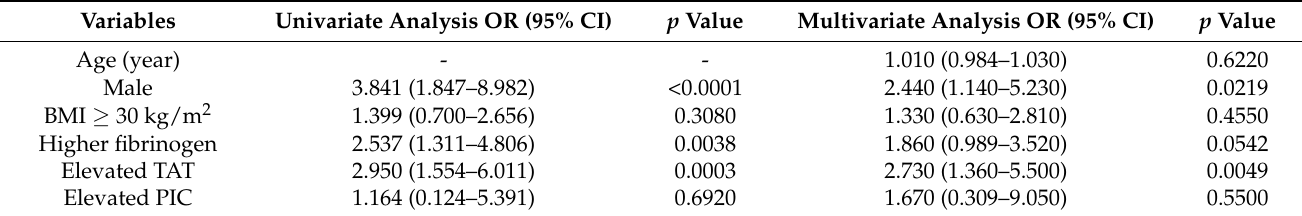
Table 4. Factors associated with severe respiratory failure in subjects with normal D-dimer.